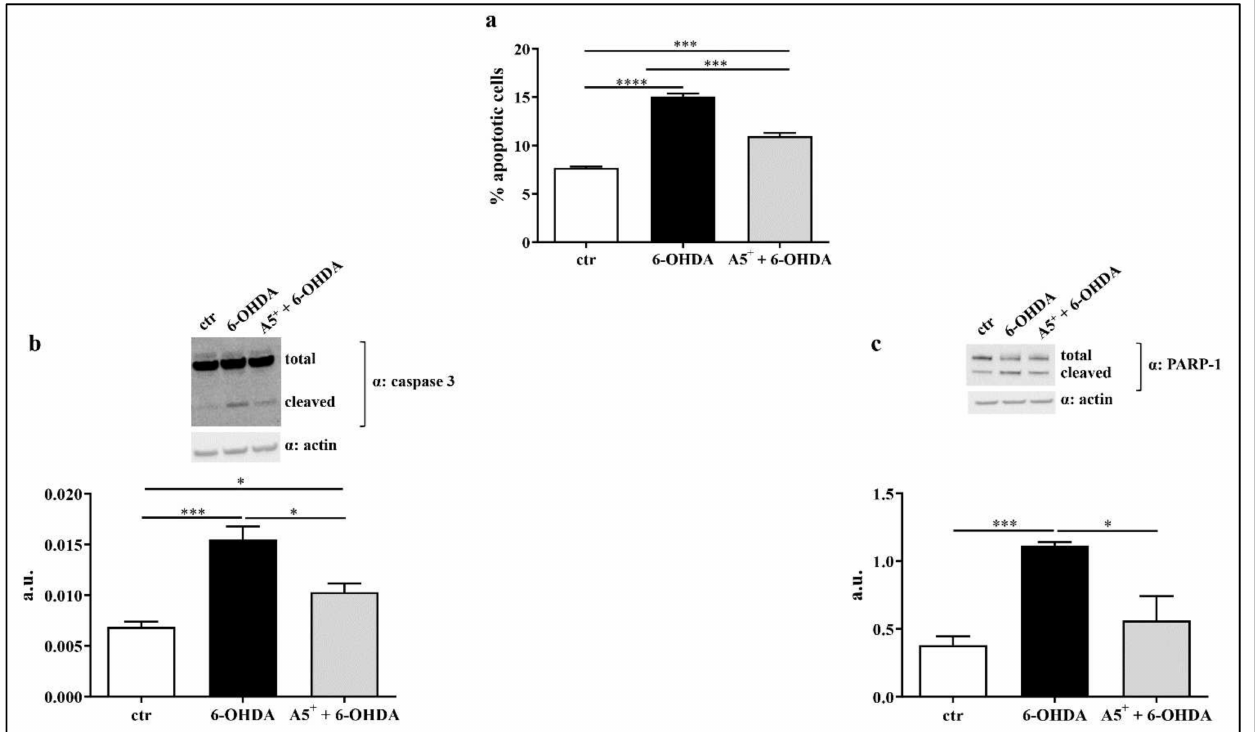
Figure 4. A5 + blunted 6-OHDA-induced apoptosis. ( a ) Sub-G1 phase assessment by cytofluorimetric analysis. ( b ) Caspase 3 cleavage. ( c ) PARP-1 activation. Data are reported as mean ± SEM. Graphs represent one of three separate studies, all yielding similar results ( n = 4). (* p < 0.05; *** p < 0.001; **** p < 0.0001). ctr: control; 6-OHDA: 6-hydroxydopamine. a.u. = arbitrary